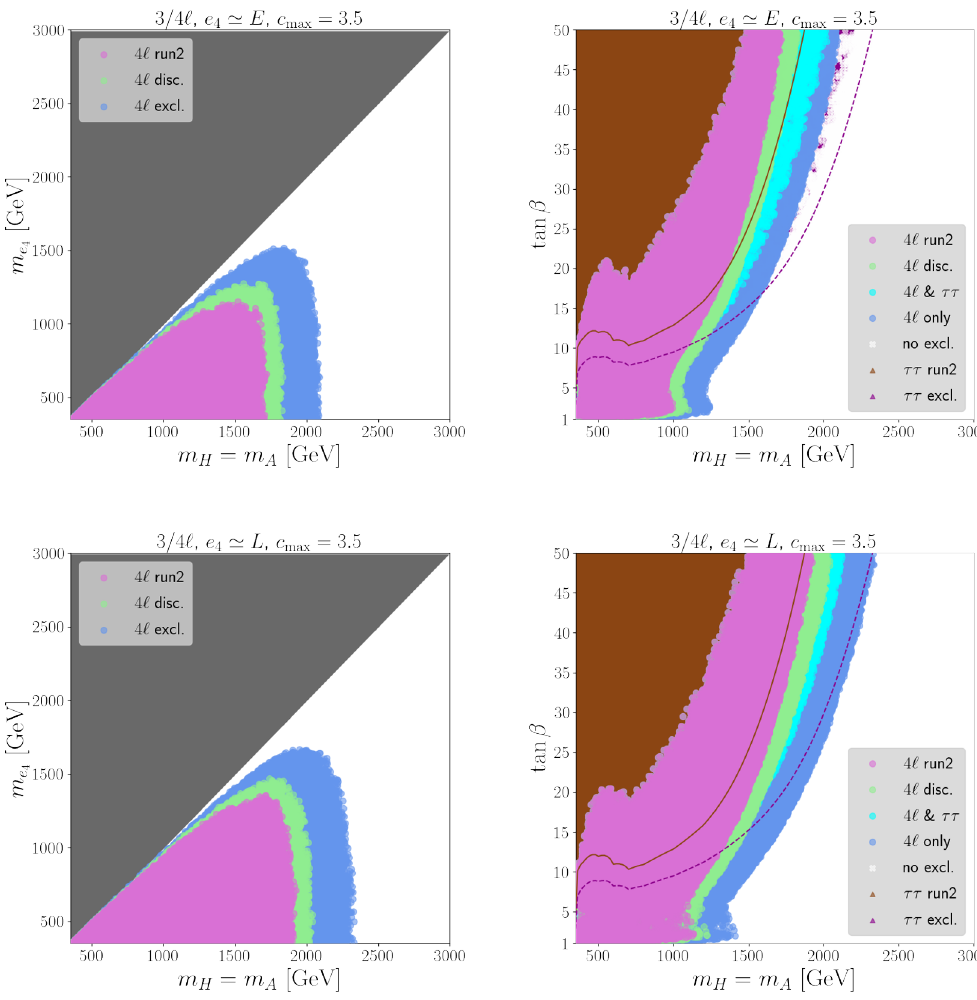
Figure 15 . Sensitivities of the 3 / 4 ‘ search to the light-E (light-L) scenario with c max = 3 . 5 in the upper (lower) panels. The labels are the same as those in figure